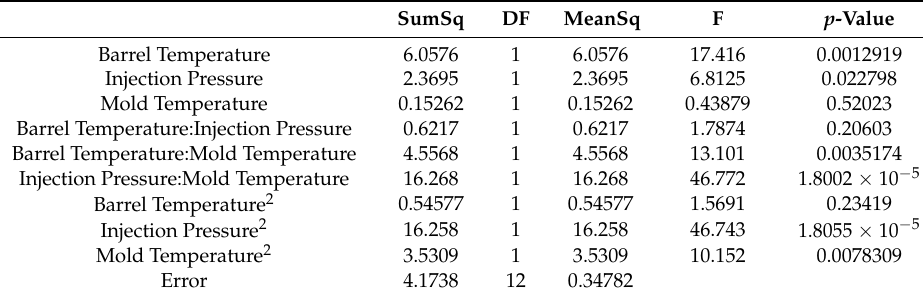
Table 3. Analysis of variance (ANOVA) for obtainable roughness.